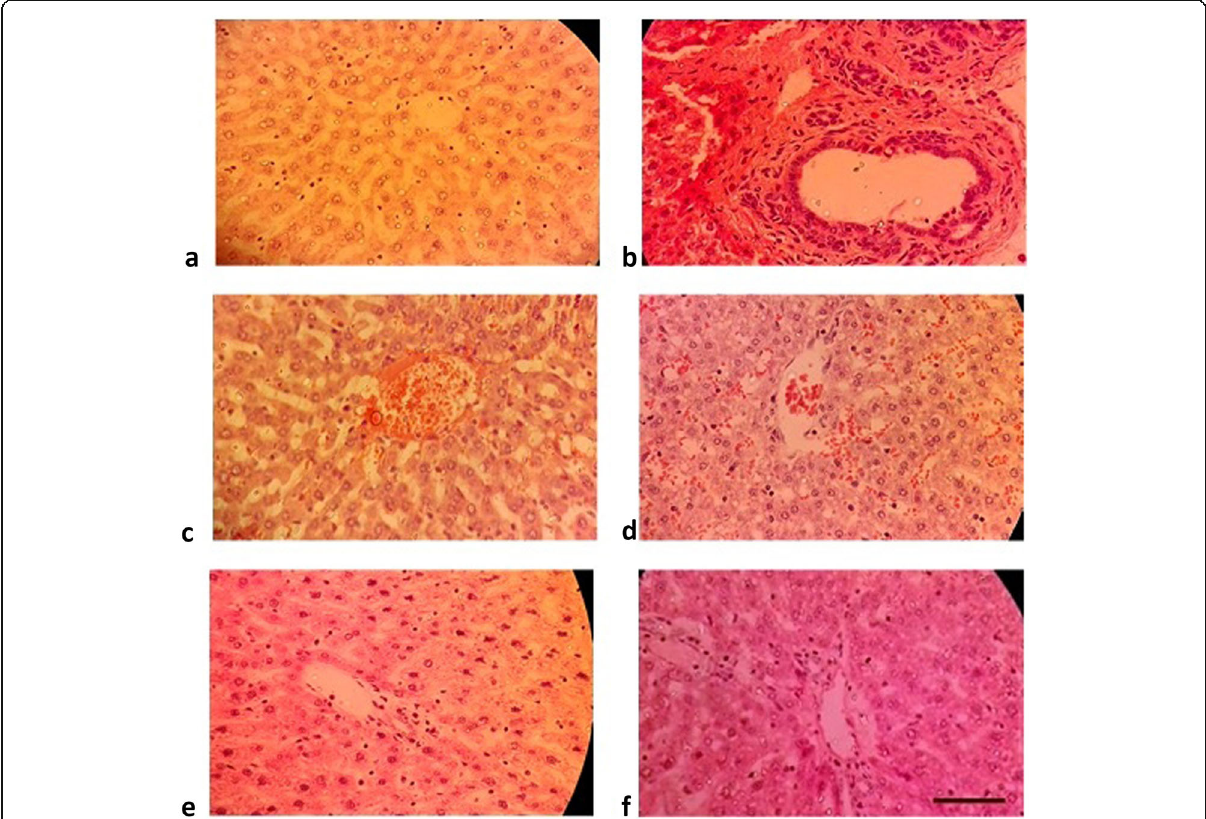
Fig. 3 Histopathology of liver. Each picture is a representative for each group as follows: a = Healthy control, b = Diabetic control, c = Diabetic control + 10 mg/kg of gliclazide, d = Diabetic control + 100 mg/kg CRME, e = Diabetic control + 200 mg/kg CRME, f = Diabetic control + 400 mg/kg CRME. Each group was evaluated at 400 x magnification, scale bar: 40 μ